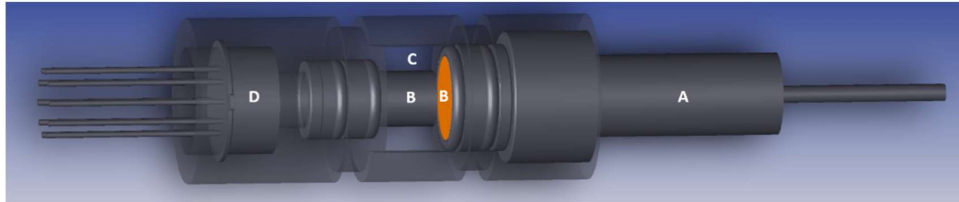
Figure 8. Cross-sectional schematic of microsensor. ( A ) light source, ( B ) Sapphire window ( right ) and rod (left), ( C ) fluid flow path, and ( D ) quad